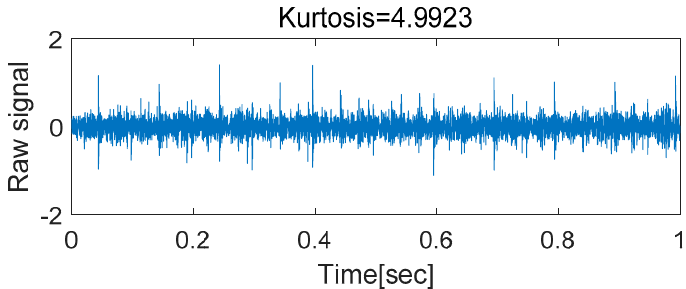
Figure 13. Raw vibration signals (bearing 1).